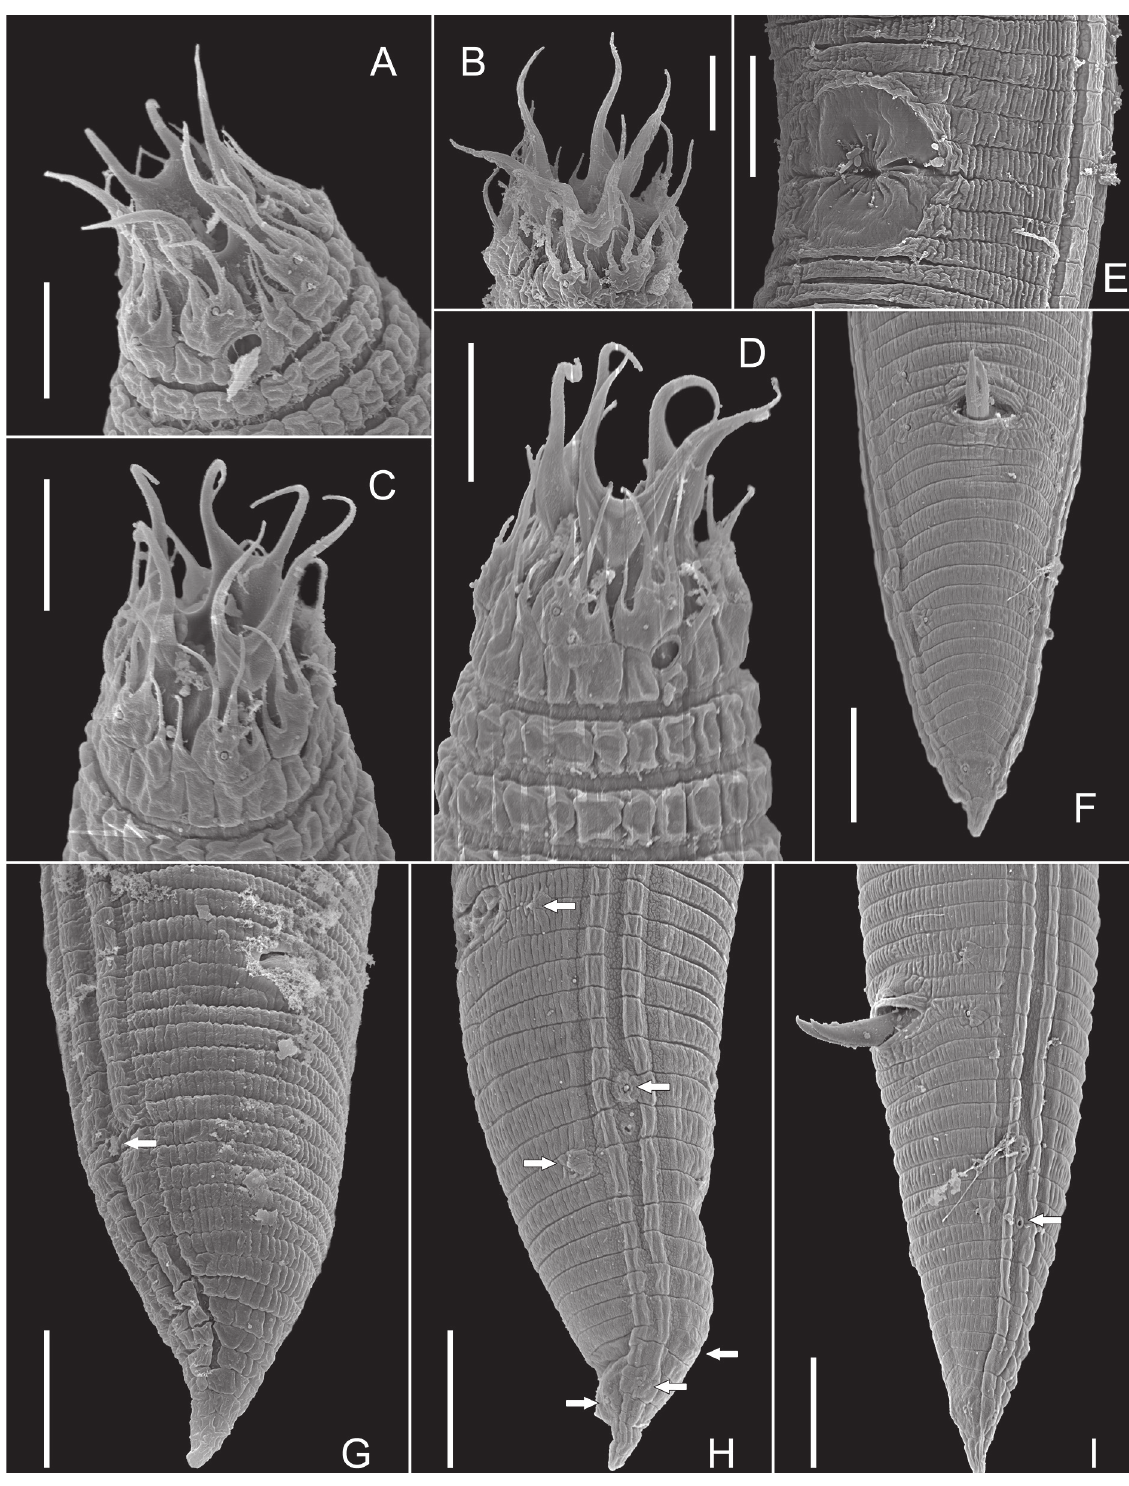
Fig. 2. Paracrobeles kelsodunensis sp. nov. SEM micrographs. A . Anterior end, left lateral view. B . Anterior end, semi-en face view. C–D . Anterior end, subventral view. E . Vulval region. F . Male tail, ventral view. G . Female tail, right sublateral view (arrow points at phasmid). H . Male tail, left lateral view (arrows point at papillae). I . Male tail, left lateral view (arrow points at phasmid). Scale bars: A–D = 5 µm, E–I = 10